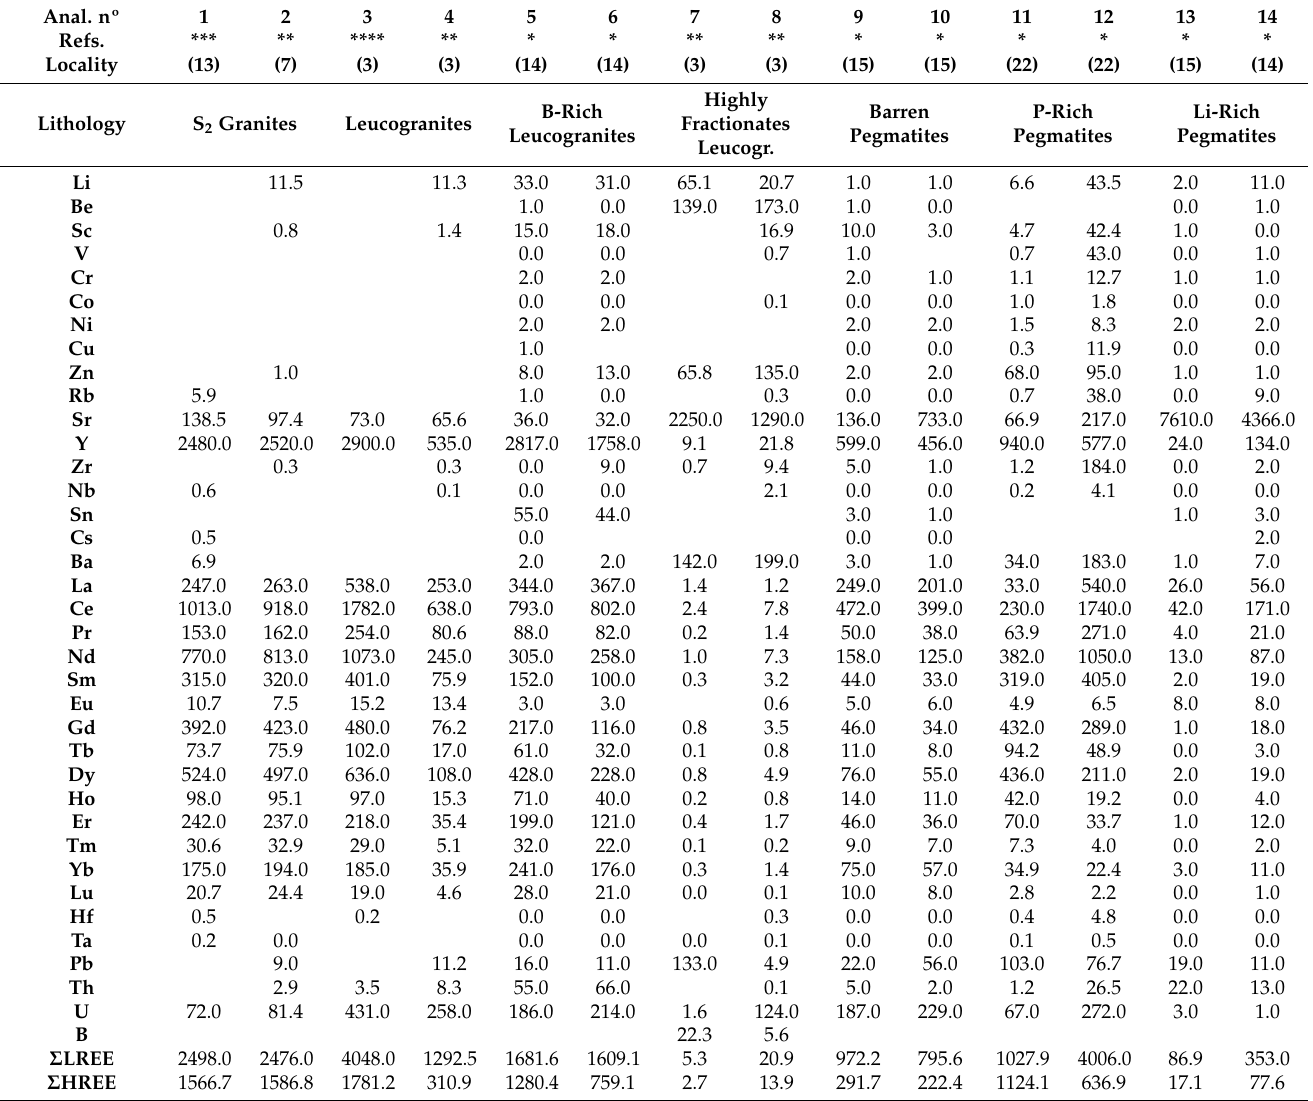
Table 5. Representative trace element analyses (values in ppm) for apatite associated with the different granitic and pegmatitic lithologies from the CIZ. Locality number as in Figure 1 and Table 1. References: * this work; ** Merino-Mart í nez [86]; *** Errandonea-Mart í n [103]; **** P é rez-Soba et al.,